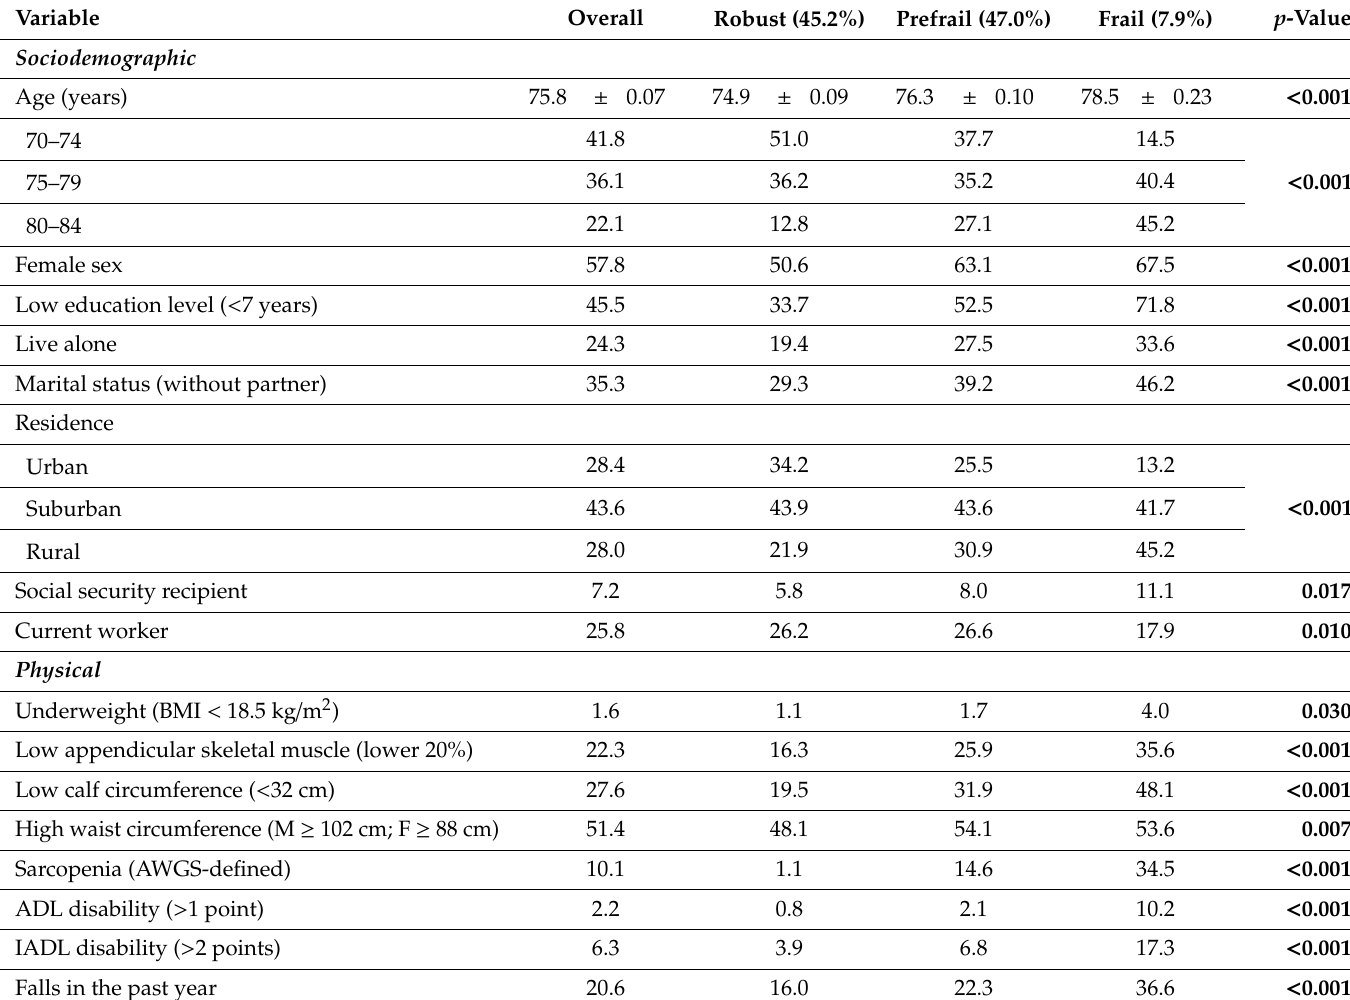
Table 3. Characteristics of the standardized study sample according to frailty